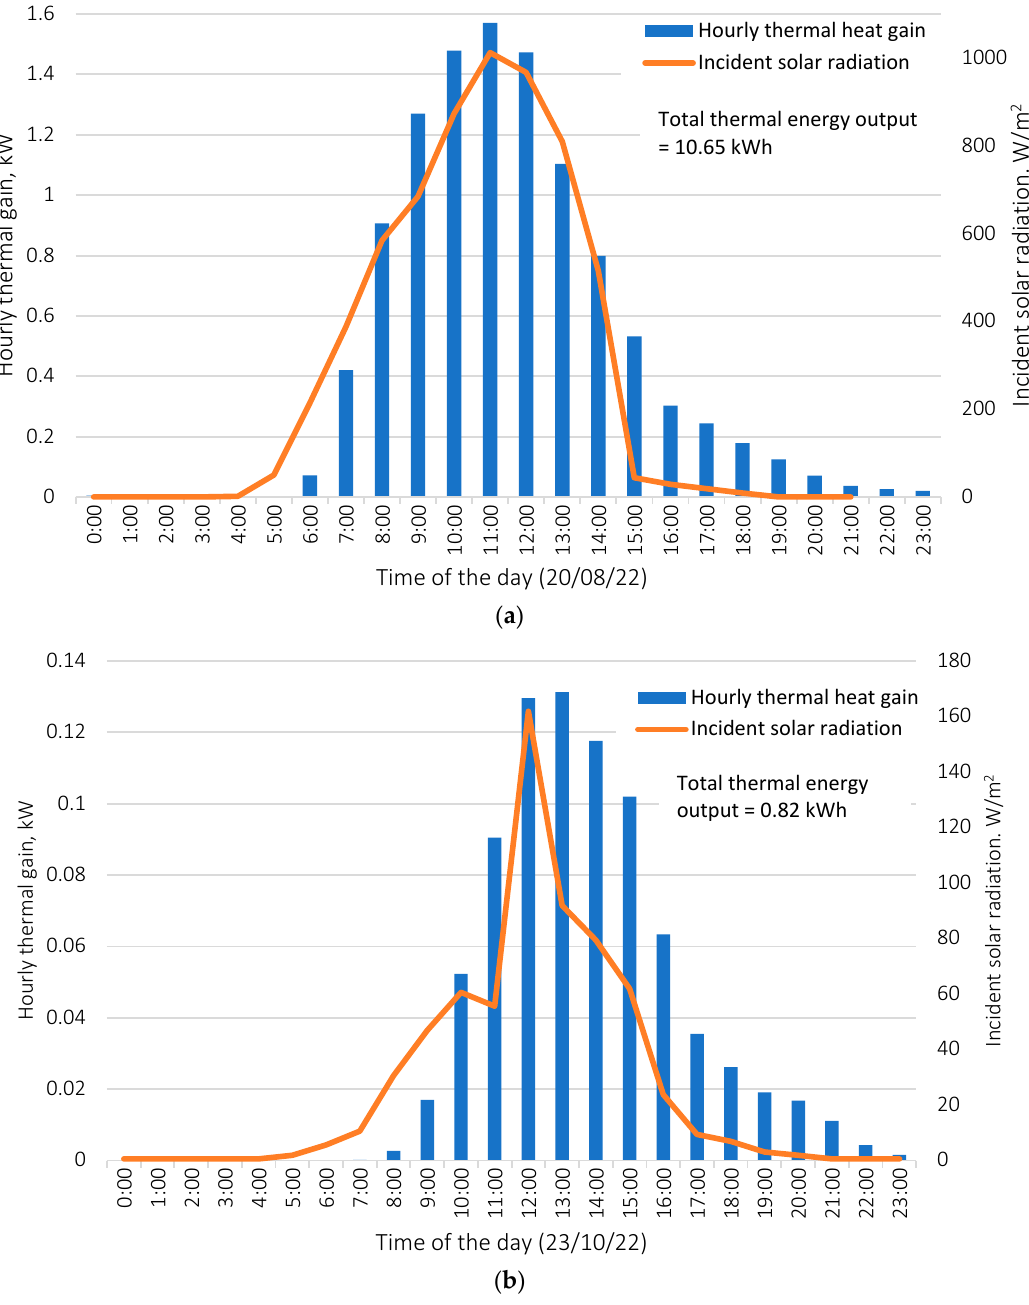
Figure 5. ( a ). Hourly thermal energy production (kWh) on a clear day (peak incident solar radiation > 1000 kWh/m 2 ). ( b ). Hourly thermal energy production (kWh) on a cloudy day (peak incident solar radiation < 200 kWh/m 2 ).